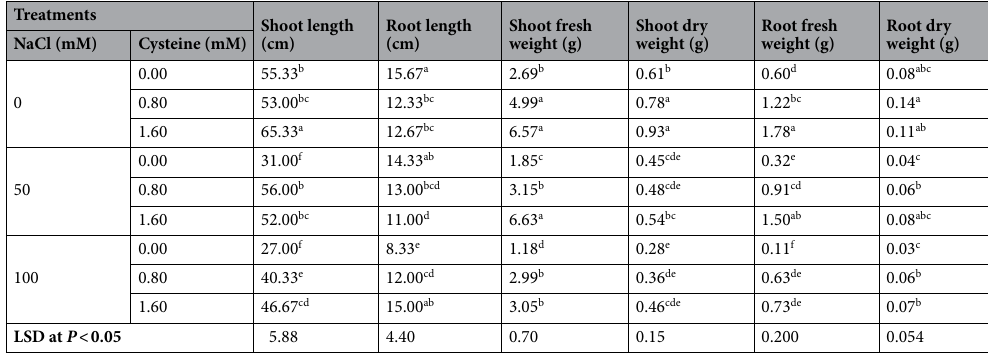
Table 1. Effect of L-cysteine on the growth criteria of the salt-stressed flax